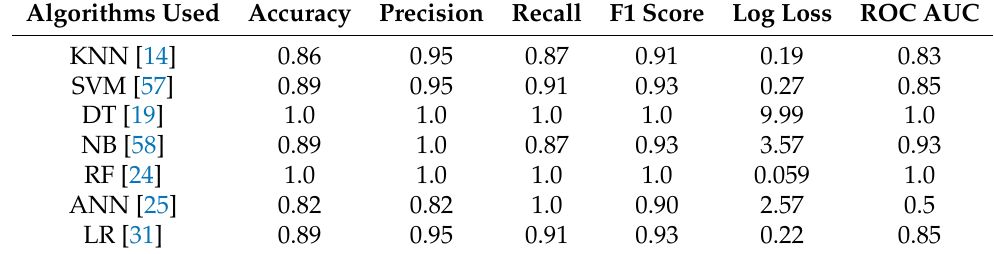
Table 8. Data exfiltration results.